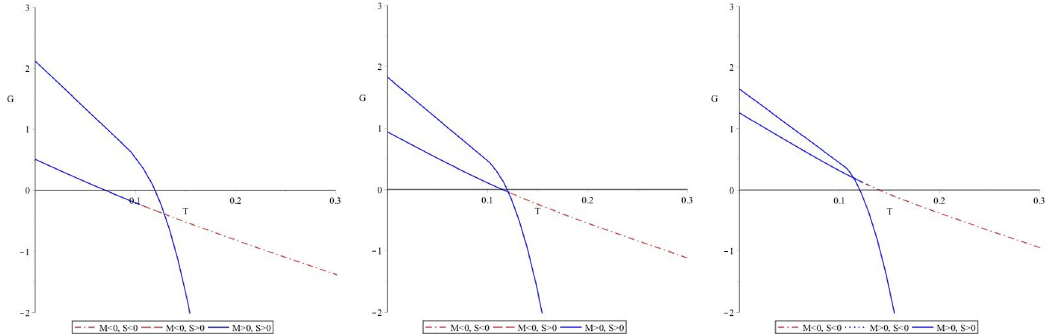
Figure 6 . Interrupted Swallowtail. For ‘ = 11 , Q e = 1 and a range of values of n , we observe an interrupted swallowtail, where the usual large/small transition is unstable, and instead a large/tiny first order phase transition takes place as temperature decreases. Blue solid lines correspond to M > 0 , whereas red dashed lines correspond to M < 0 . For large enough n this transition will be for M > 0 , shown in the right diagram. As n decreases, it reaches a threshold value ( n = 1 . 15 , shown in the middle diagram) below which the transition is from a large black hole with M > 0 to a the tiny black hole with M < 0 , shown in the left diagram. Throughout, the entropy S ( I ) > 0 at N the transition; the unstable branch at large T eventually has S ( I ) < 0 , shown by the red dot-dash N line. These structures occur in cases Ia and IIa.